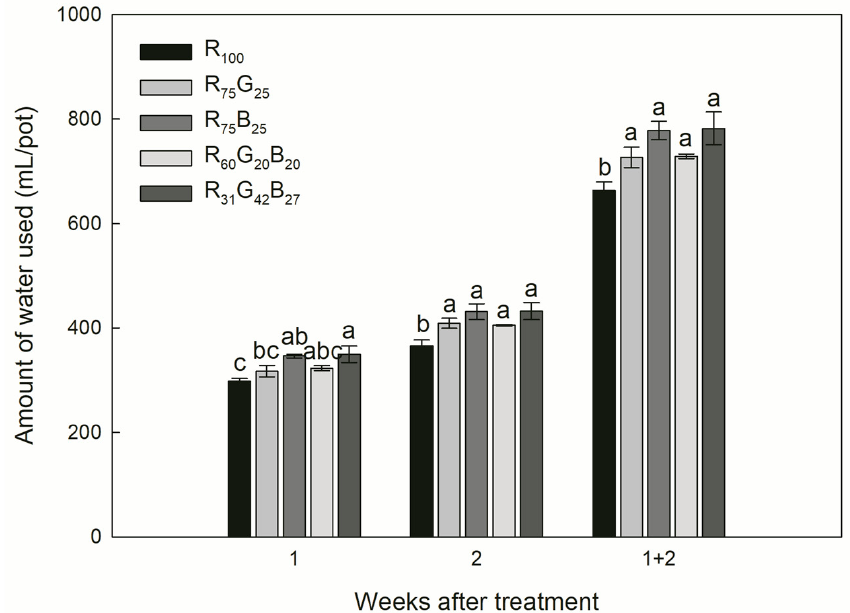
Figure 6. Total amount of water used by Ocimum basilicum grown under five different combinations of red, green, and blue LEDs with the same light intensity for 14 days. The numbers after each waveband indicate the ratios of the intensities. The R 31 G 42 B 27 treatment mimics the sunlight spectrum measured in the experimental greenhouse. Values shown represent the total water usage of the first week, second week, and the entire experimental period. Pot weights were measured using load cells, and the decrease in weight recorded every 30 min was used to calculate the amount of water used. Mean separation followed analysis of variance (ANOVA) with Duncan’s multiple range test at α = 0.05. Means with the same letter are not significantly different. Error bars indicate the standard error ( n = 3).